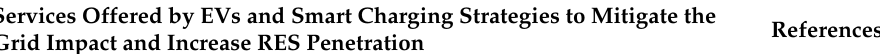
Table 1. References indicating the services that can be offered by EVs alongside the smart charging strategies to mitigate the grid impact and increase RES penetration.